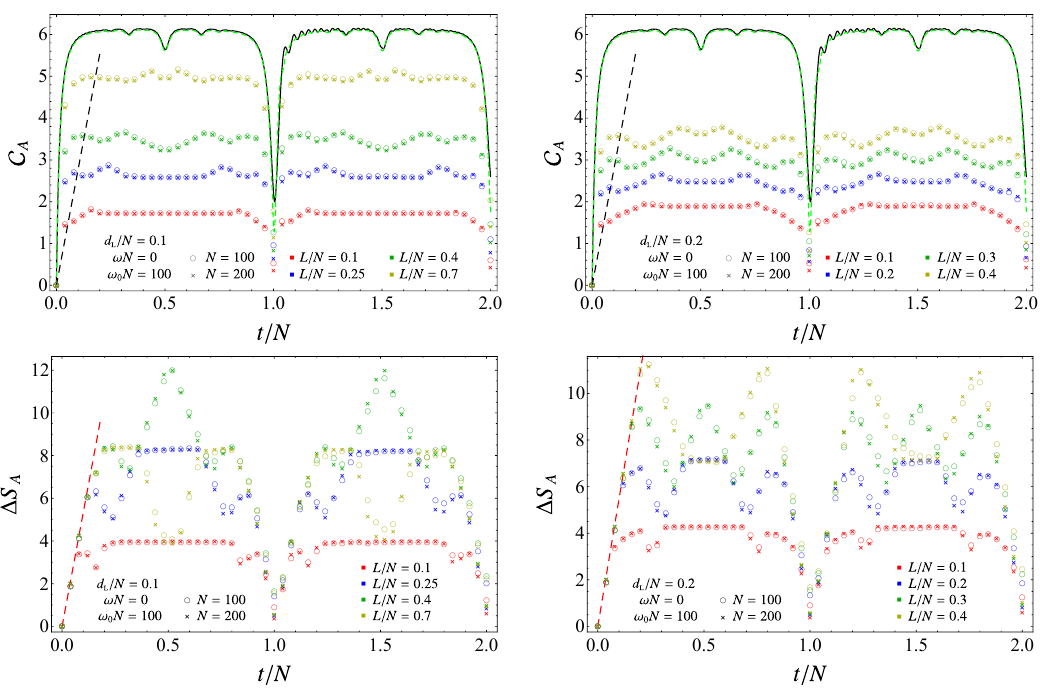
Figure 12 . Temporal evolution after the global quench with a gapless evolution Hamiltonian of C A in (4.6) (top panels) and of ∆ S A in (4.7) (bottom panels) for a block A made by L consecutive sites and separated by d sites from the left boundary of harmonic chains with DBC made by N L sites. When L = N , the complexity (3.7) is shown for N = 100 (solid black lines) and N = 200 (dashed green